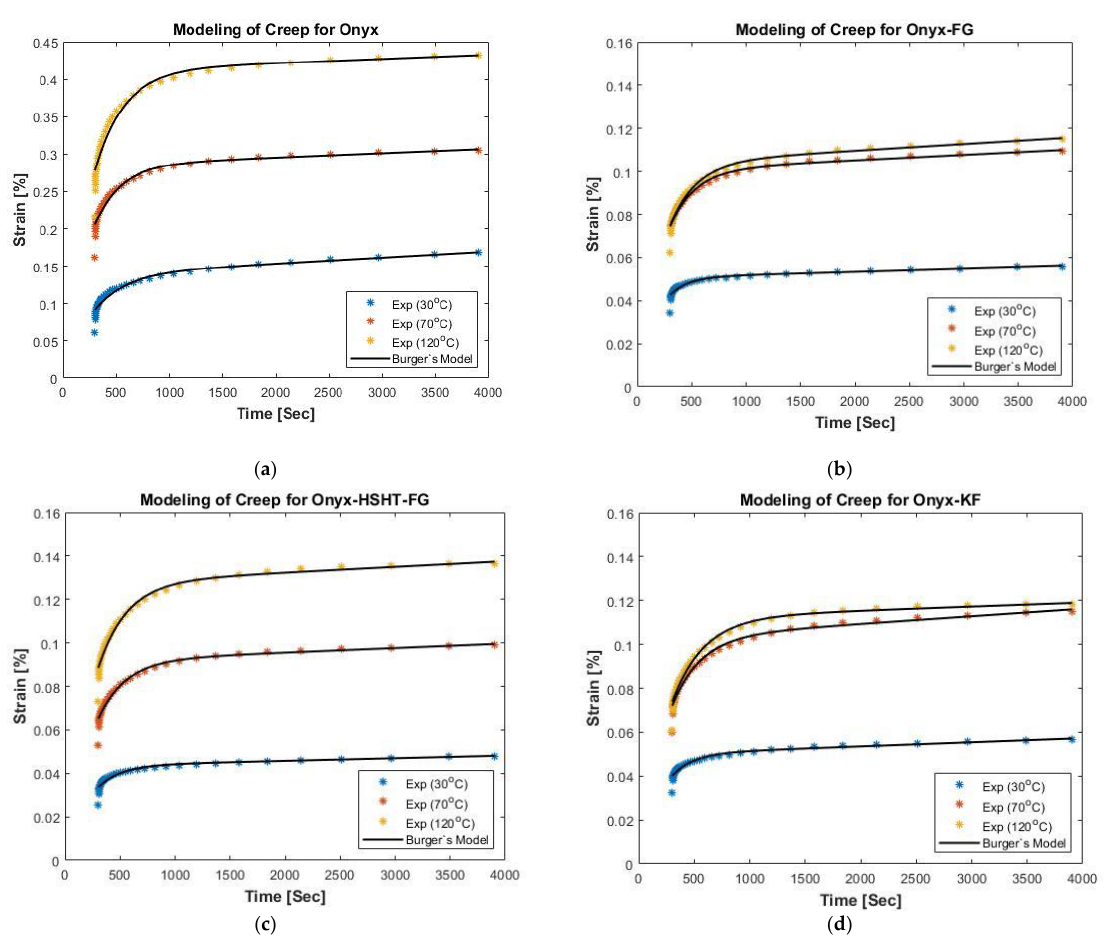
Figure 5. Modeling of creep curves for CFR3DP composites at different temperatures; ( a ) Modeling of creep for Onyx; ( b ) Modeling of creep for Onyx-FG; ( c ) Modeling of creep for Onyx-HSHT-FG; ( d ) Modeling of creep for Onyx-KF. Table 2. Simulated parameters of the Burger’s model.